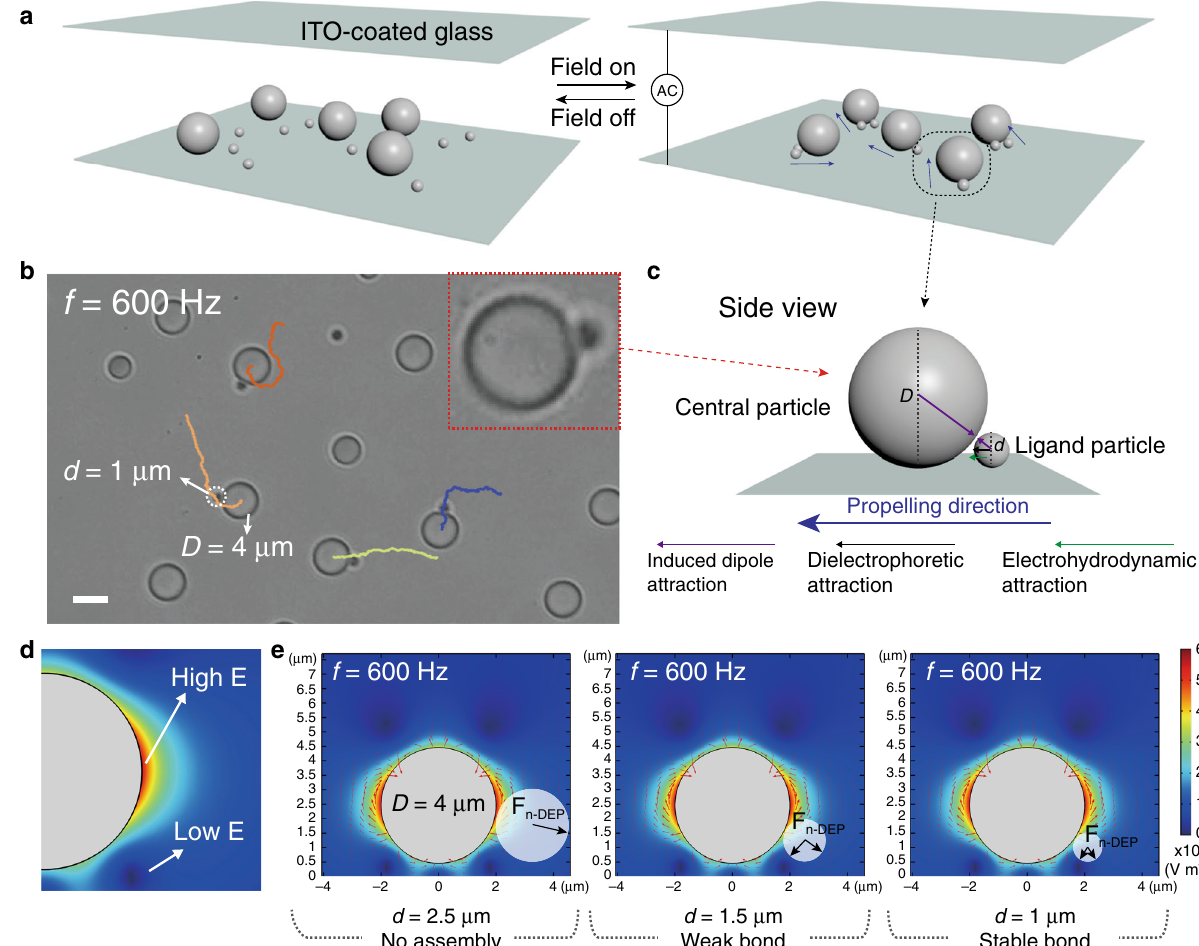
Fig. 1 Colloidal molecules by purely dielectric spheres of different sizes. a Schematic illustration of experimental setup for the assembly of colloidal molecules under AC electric fi eld. b Optical microscope image showing the AB colloidal molecules and their propulsion trajectories. Dielectric spheres 1 and 4- µ m (diameter, d and D ) are used. c Cartoon of an AB colloidal molecule (a side view) and various interparticle forces that account for its formation and dynamics. The larger 4- µ m particle is referred to as the central sphere; the smaller 1- µ m is referred to as the ligand. d , e Finite-element analysis of the nonuniform electric fi eld locally distributed around a dielectric sphere ( D = 4 µ m) at AC frequency f = 600Hz, showing the high- fi eld and low- fi eld region ( x – z plane). A negatively polarized particle (e.g., dielectric) experiences negative dielectrophoretic (n-DEP) forces, being attracted towards the low- fi eld region and/ or repelled by the high fi eld according to its size. Red arrows represent the direction of electric fi eld lines. Color bar: electric fi eld strength. Scale bar: 4 μ exhibiting regions of low fi eld, both above and beneath the particle, as well as regions of high fi eld around the particle equator. In response to this nonuniform electric fi eld, a second dielectric particle (the ligand) of a small size can be trapped in the low- fi eld region, forming a bond due to negative dielectrophoretic force, or n-DEP. A bigger ligand particle can feel the high fi eld from the equator and thus be repelled, disfavoring a bond. Instead, a metallic particle as a ligand will be attracted to the equator or avoid being attracted at the bottom part of the central particle by positive DEP force (p-DEP), according to its size. We simulate the nonuniform electric fi eld around the central sphere by a fi nite-element calculation, considering the AC response of the particle ’ s electric double layer (EDL) (see “ Methods ” section). Figure 1d displays a cross section ( x – z plane) of the electric fi eld distribution around a 4-µm polymer particle at f = 600 Hz, showing the referred regions of low and high fi eld. Dielectric ligand particles of different sizes are fi tted next to the central particle; the directions of DEP are shown to reveal the various bonding scenarios depending on the particle sizes (Fig. 1e).